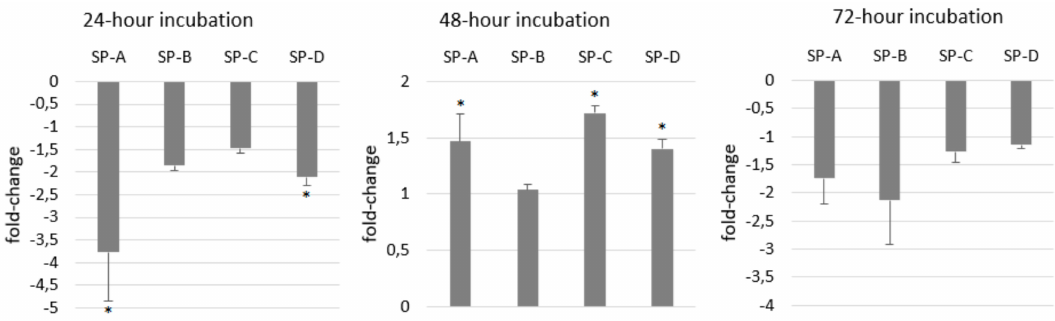
Figure 6. The e ff ect of LPS on surfactant proteins’ (SPs) gene expression in A549 cells. LPS at concentration of 100 µ g / mL decreased gene expression of all SPs after 24 and 72 h and increased expression after 48 h. Gene expression in untreated cells represents the basal (zero) line. Data are presented as means ± SDs from three independent experiments. * p < 0.05. LPS—lipopolysaccharide, SPs—surfactant